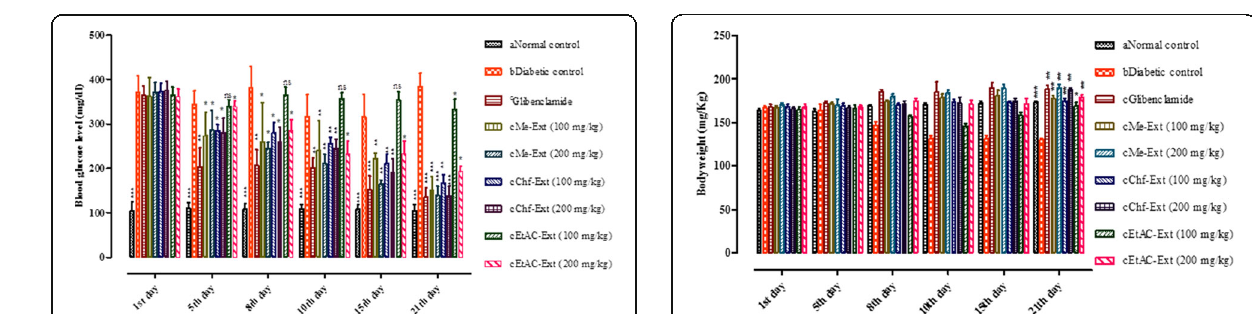
Fig. 6 Effects of E. umbellata fruit methanolic extracts/fractions on body weight in STZ-induced diabetic rats. Each value is Mean ± SEM of 8 animals. Comparisons were made between anormal control to b diabetic control using student t-test (*** P < 0.001) and between b diabetic control to positive control c (Glibenclamide/extracts treated groups) using one way ANOVA followed by Dunnett ’ s multiple comparison test (* P < 0.05, ** P <